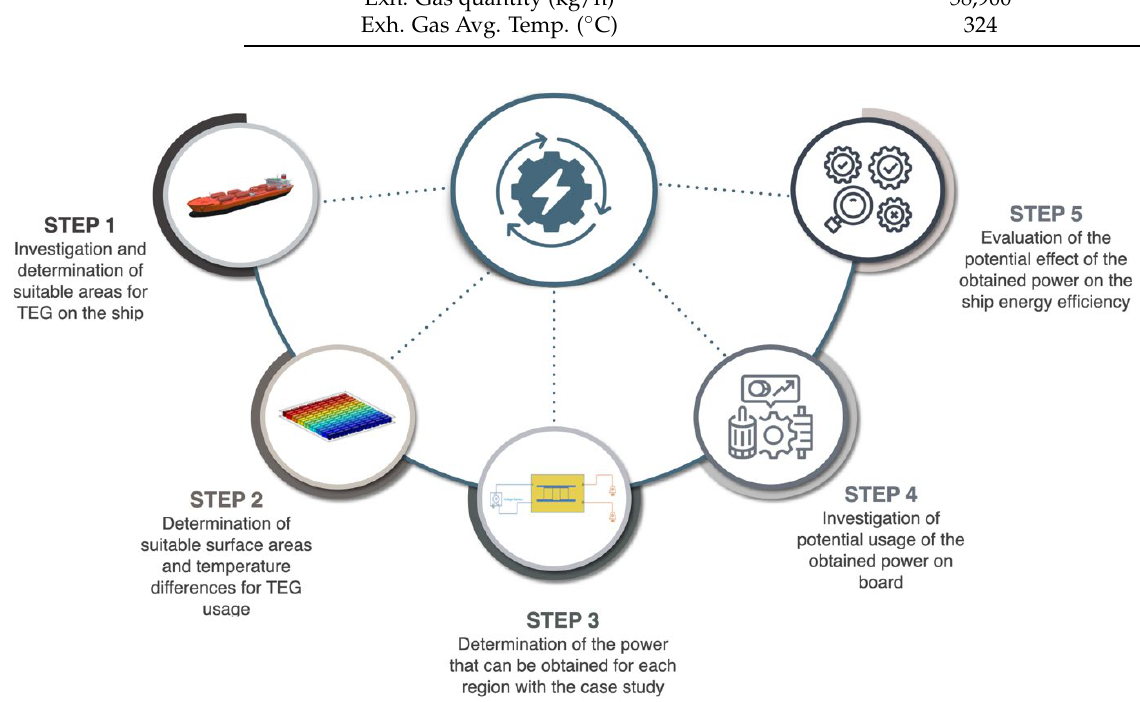
Figure 1. Methodology of the study.